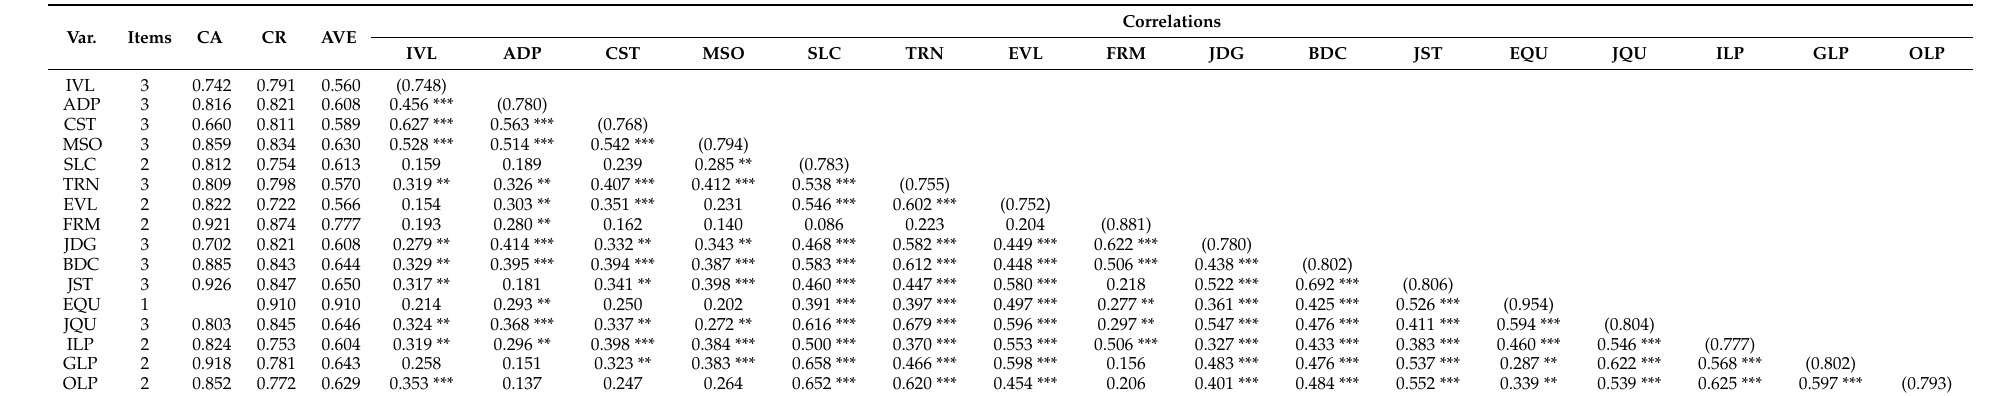
Table 3. Descriptive statistics and correlation